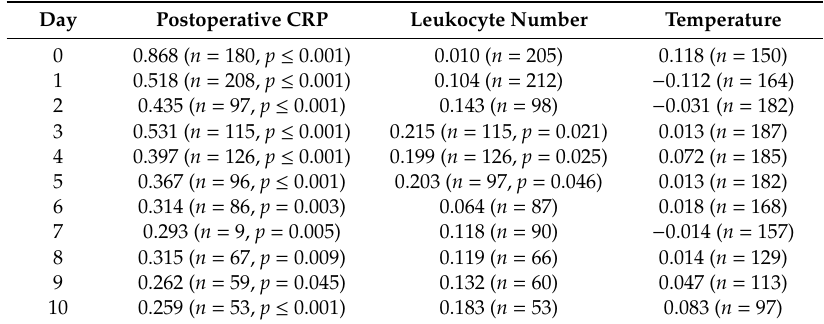
Table 2. Linear regression analysis of preoperative C-reactive protein (CRP) values versus postoperative CRP, leukocyte number and body temperature ( n = 217).